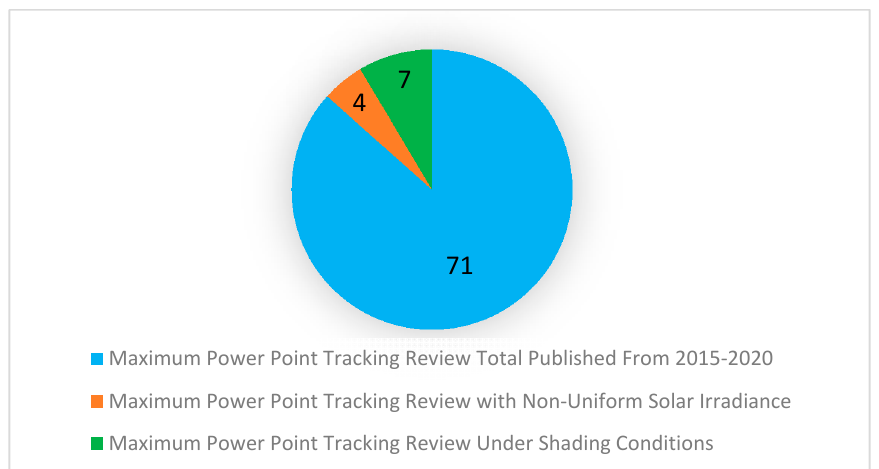
Figure 5. Maximum power point tracking Google Scholar search.